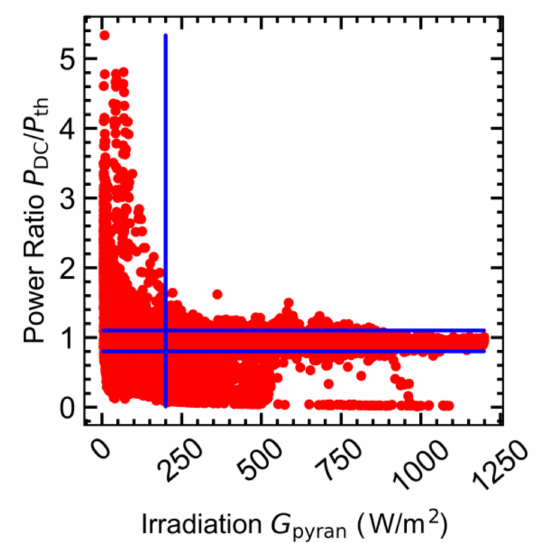
Figure 2. Exemplary correlation of the power ratio and in-plane solar irradiance, for the a170Ni system in Nicosia, Cyprus, over a time frame of 1